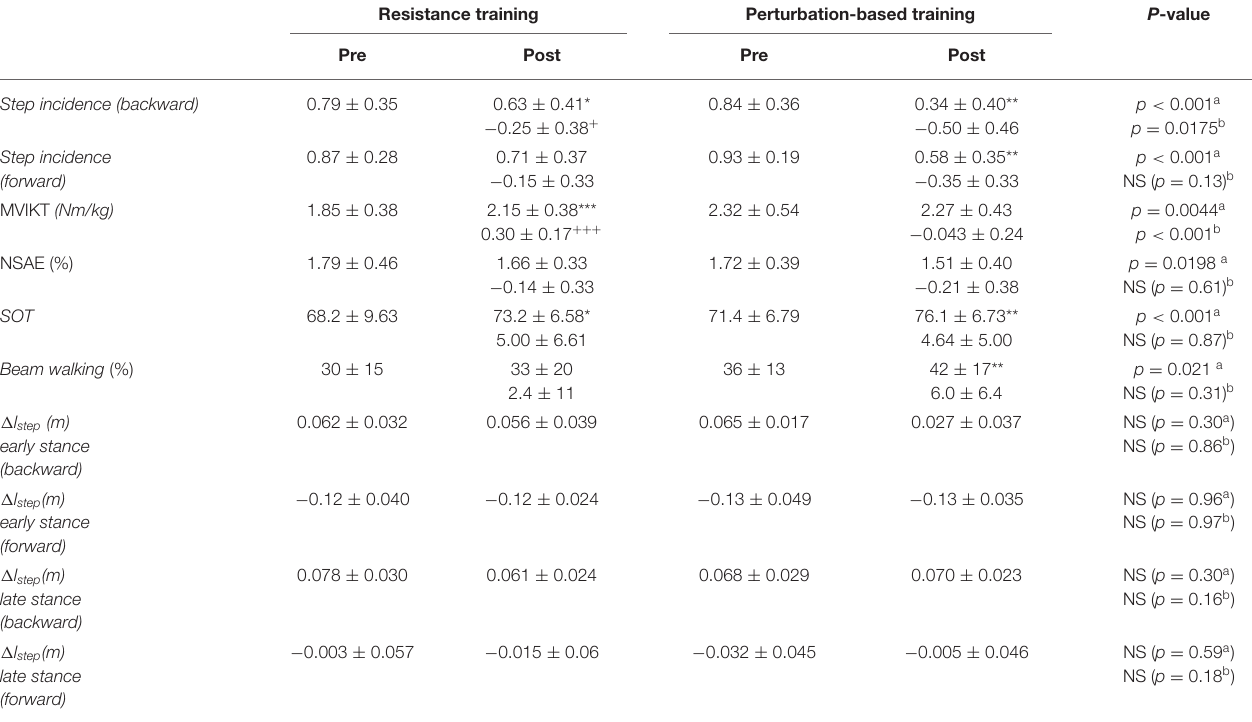
TABLE 3 | Pre -to post-training comparisons for different outcome variables that were defined a-priori. Resistance training